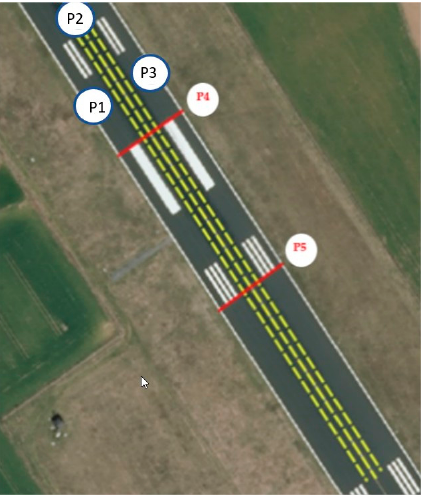
Figure 3. Scope of the experiment and sections considered.